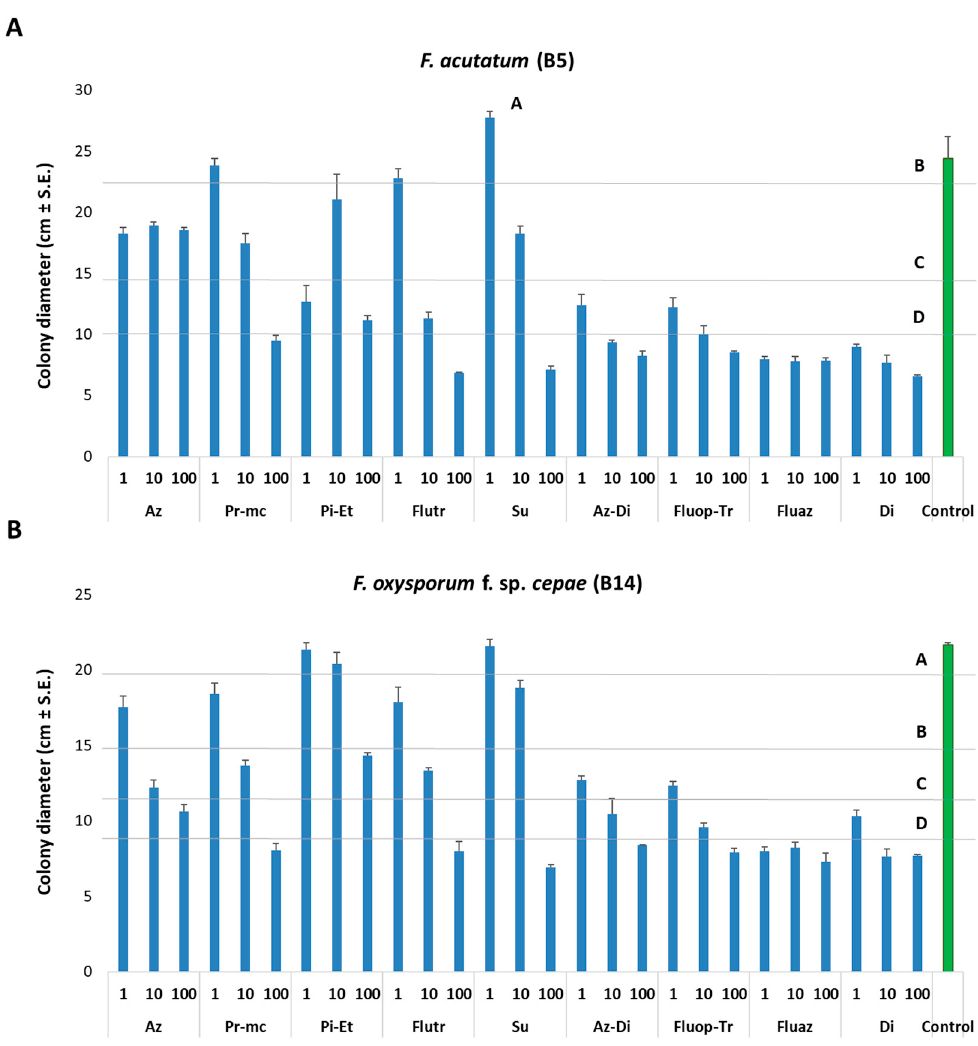
Figure 1. The effect of selected pesticides on the development of F. oxysporum f. sp. cepae ( A , strain B14) and F. acutatum ( B , strain B5) in culture plates. The pesticides were tested at concentrations of 1, 10, and 100 ppm. Mycelial discs from a 8-day-old colony were sown on potato dextrose agar (PDA) medium plates that contained pesticides in three concentrations and incubated for two days. Controls (green columns) are PDA without fungicides. Bars represent the mean colony diameter of four replicates, and error bars signify a standard error. Different letters (A–D, on the chart’s right side) represent a significant difference ( p < 0.05) in the ANOVA test.